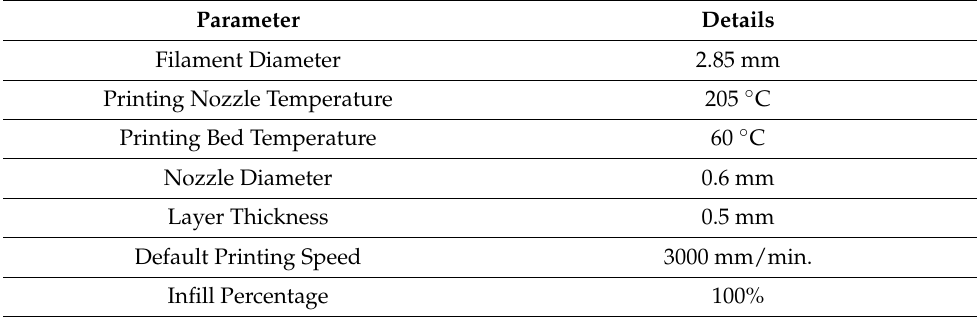
Figure 1. ( a ) Photograph of the BigRep ONE printer and ( b ) a schematic diagram of the three-dimensional printing process. A set of four scaled sizes of solid cube, with an edge length of 20n mm, where n = ¼ , Table 1. Parameters employed for manufacturing the test